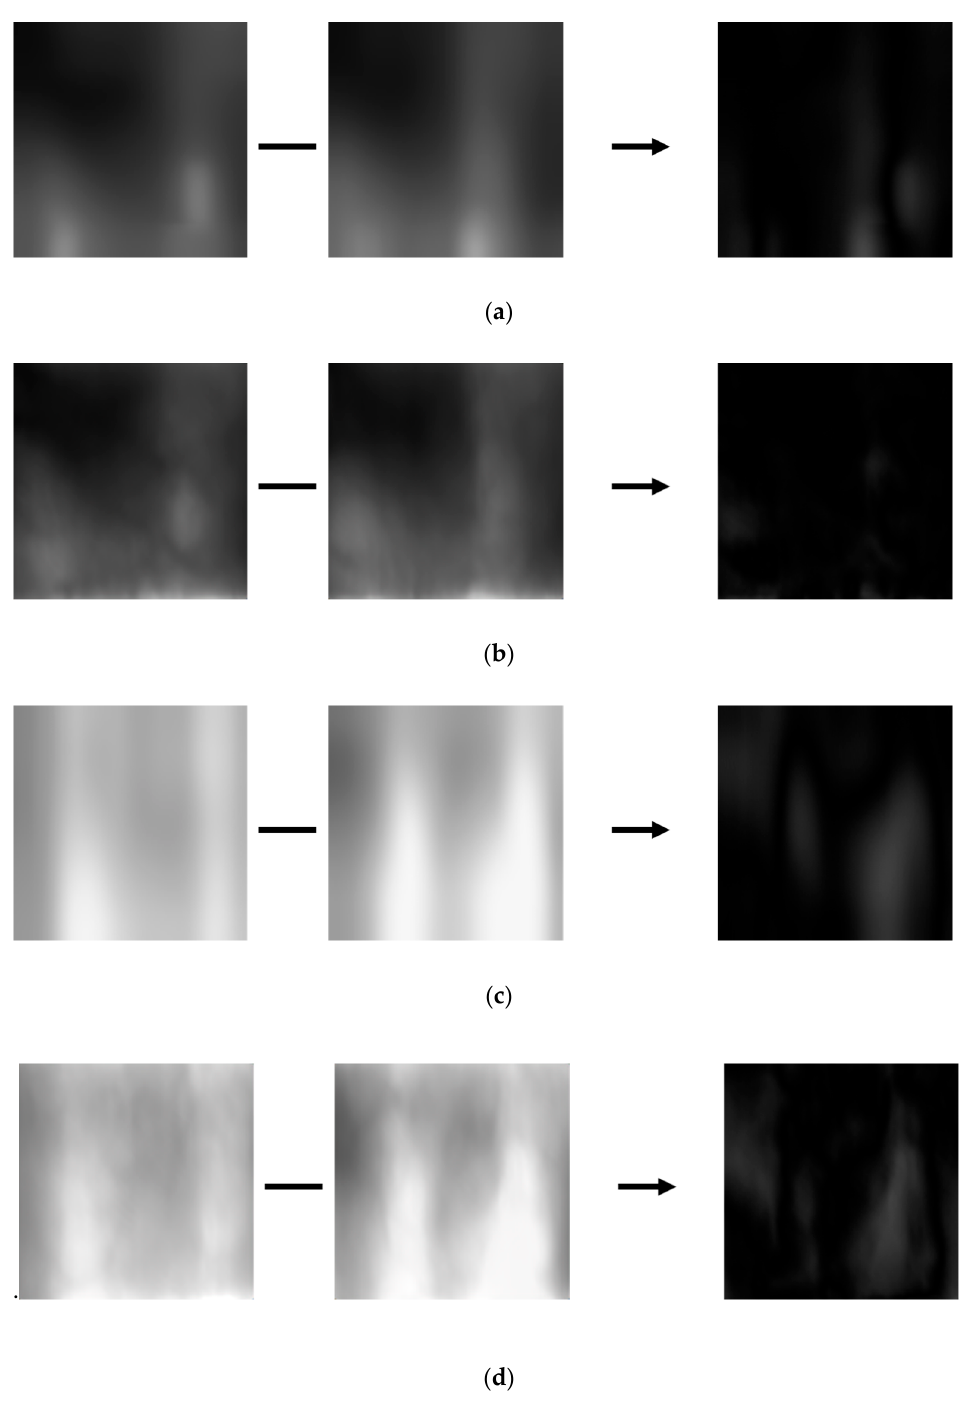
Figure 36. Correct recognition examples after restoring motion and optical blur. ( a ) Incorrect genuine matching before restoration, ( b ) correct genuine matching after restoration, ( c ) incorrect imposter matching before restoration, and ( d ) correct imposter matching after restoration. From the left, examples in ( a – c ) and ( d ) present the enrolled, matching, and difference images, respectively.